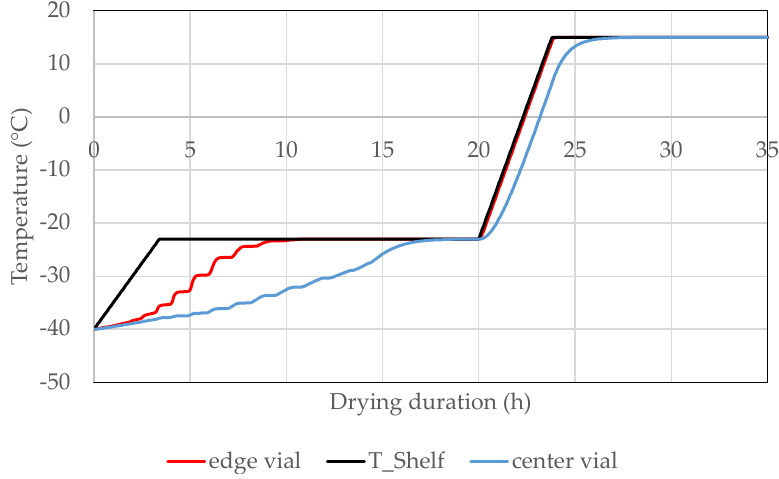
Figure 11. Shelf and product temperature profiles.